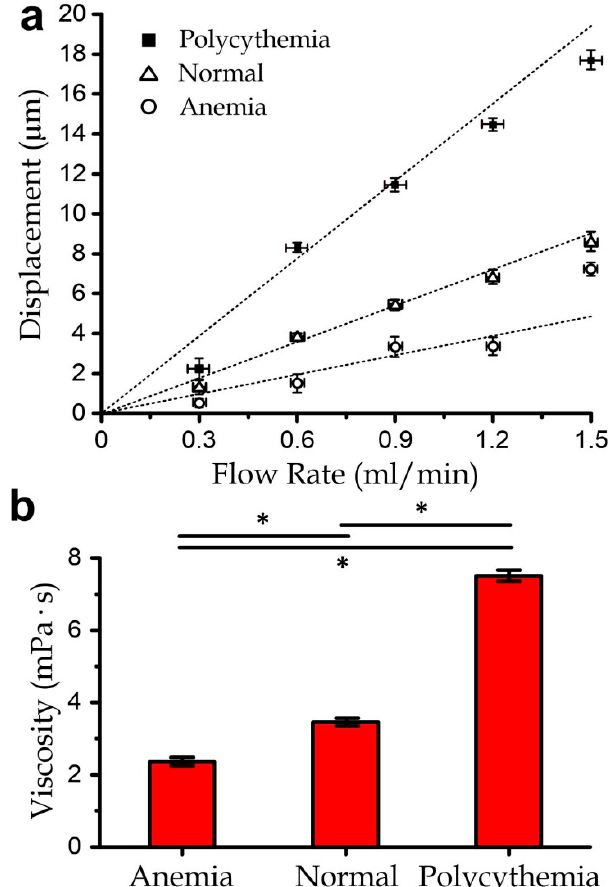
Figure 5. ( a ) Micromembrane displacements for anemia, normal, and polycythemia bovine blood samples for different sample flow rates. Dotted lines are fitting lines. All error bars are standard errors ( N ≥ 5). ( b ) Comparison of measured viscosity values for different blood samples. All error bars are standard errors. Asterisks indicate a p ‐ value < 0.05.